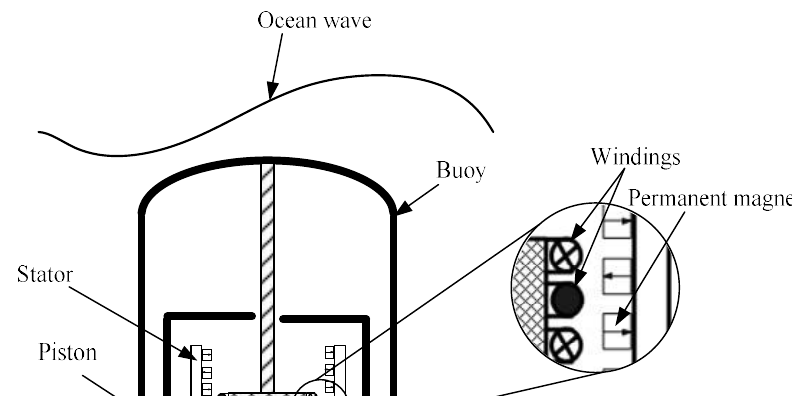
Figure 1. Sketch of Wavegen Limpet.